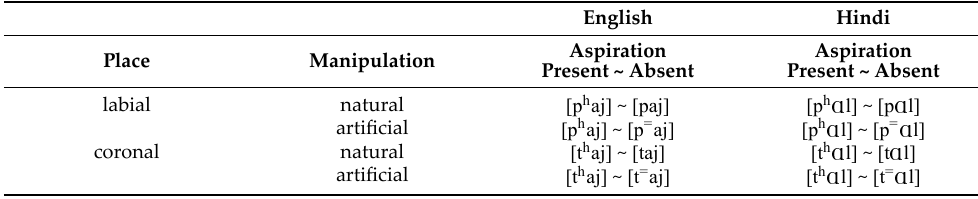
Table A2. The 8 pairs of filler stimuli used in the main task, with each pair differing in the pres‑ ence/absence of aspiration. Hindi coronal stops are all dental; the dental diacritic is omitted for readability. [p = ] and [t = ] refer to tokens where aspiration has been artificially removed from natu‑ rally aspirated tokens. Note that four of the individual items (English [paj, taj] and Hindi [p a l, t a l] ) are also used in target pairs (see Table 3).